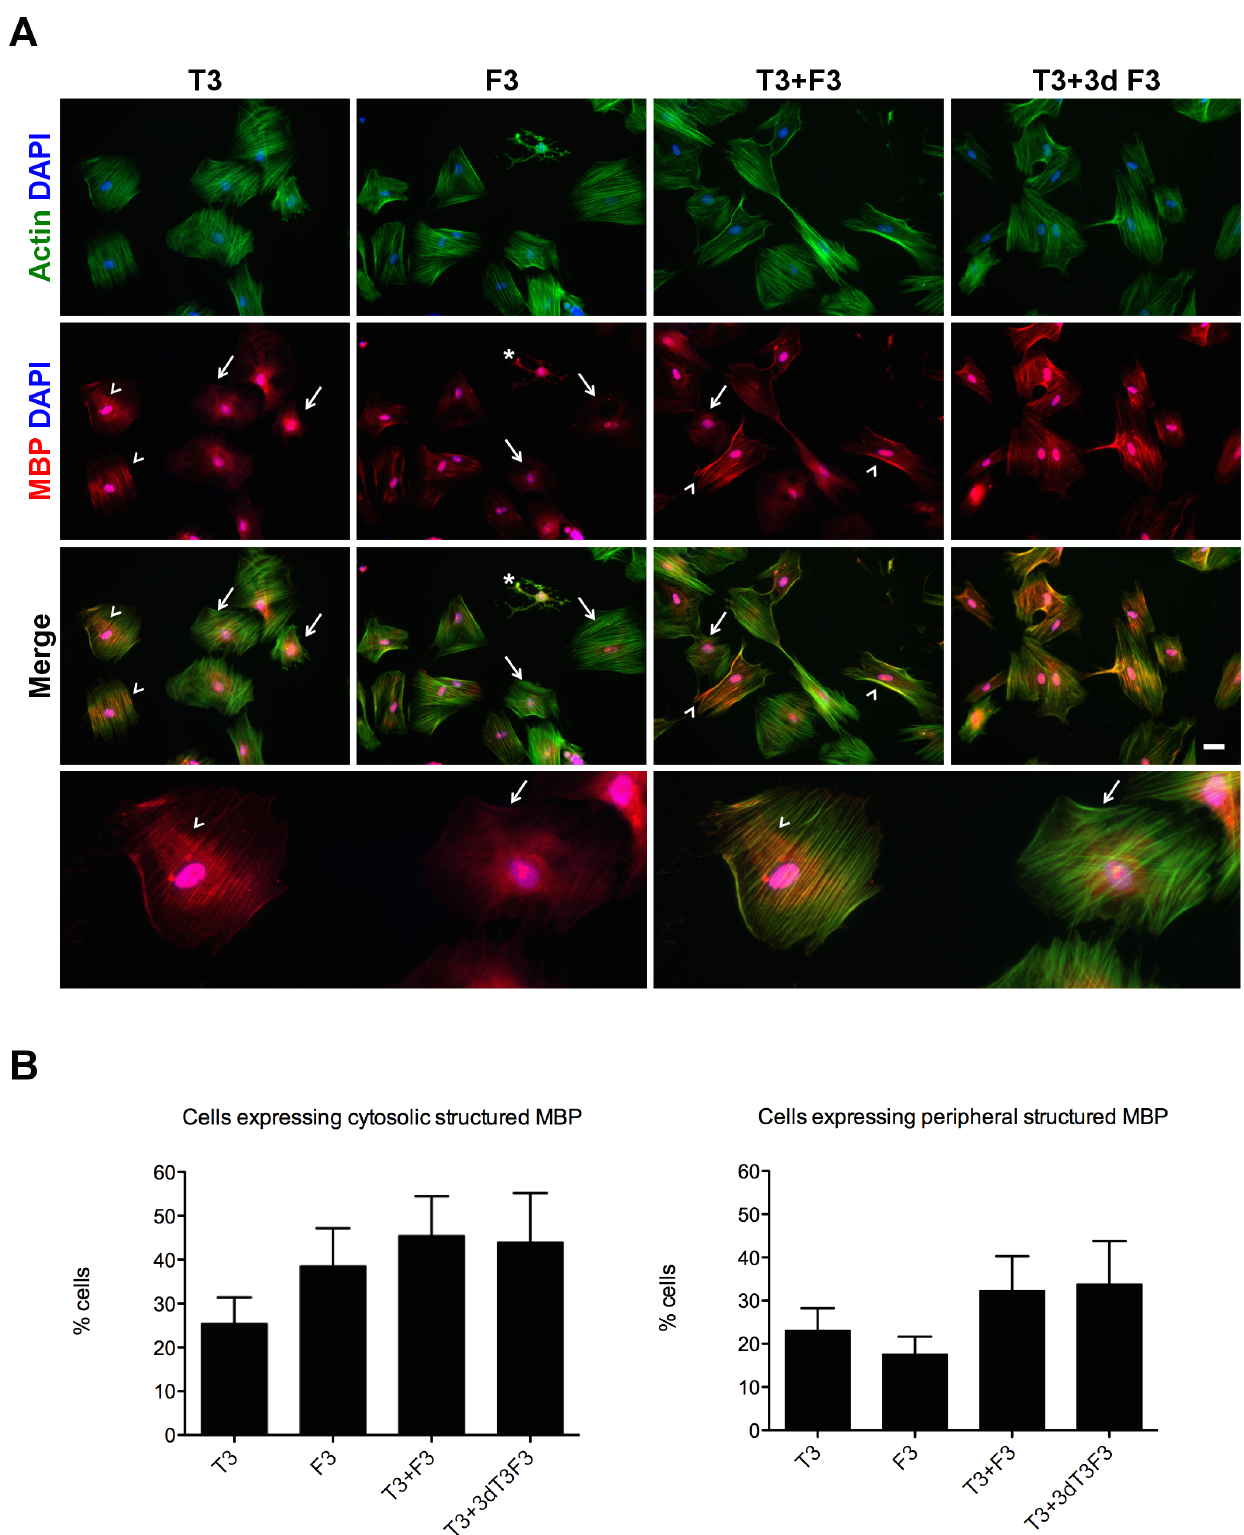
Figure 8. Co-localization of MBP and F-actin in oligodendrocyte-like cells. Fluorescence microscopy images of OL-like cells ( A ) stained with fluorescent phalloidin (in green) to assess the presence of polymerized actin (F-actin) and an antibody against MBP (in red) and both channels merged, as indicated. Cells were derived from OPC-like cells cultured on FN-coated wells. Cells showing structured MBP and with partial co- localization with F-actin (arrow heads) or with diffuse MBP and no co-localization with F-actin (arrows) were visible after OL-like differentiation in the presence of T3, F3, T3 + F3 or 7 days T3 followed by 3 days T3 + F3 (T3 + 3d F3), as indicated. The bottom panel is a magnification of the T3 condition.